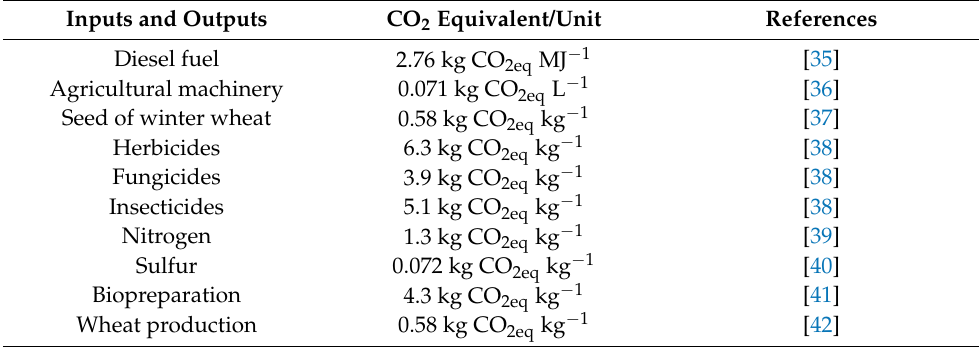
Table 4. CO 2 values for different agricultural